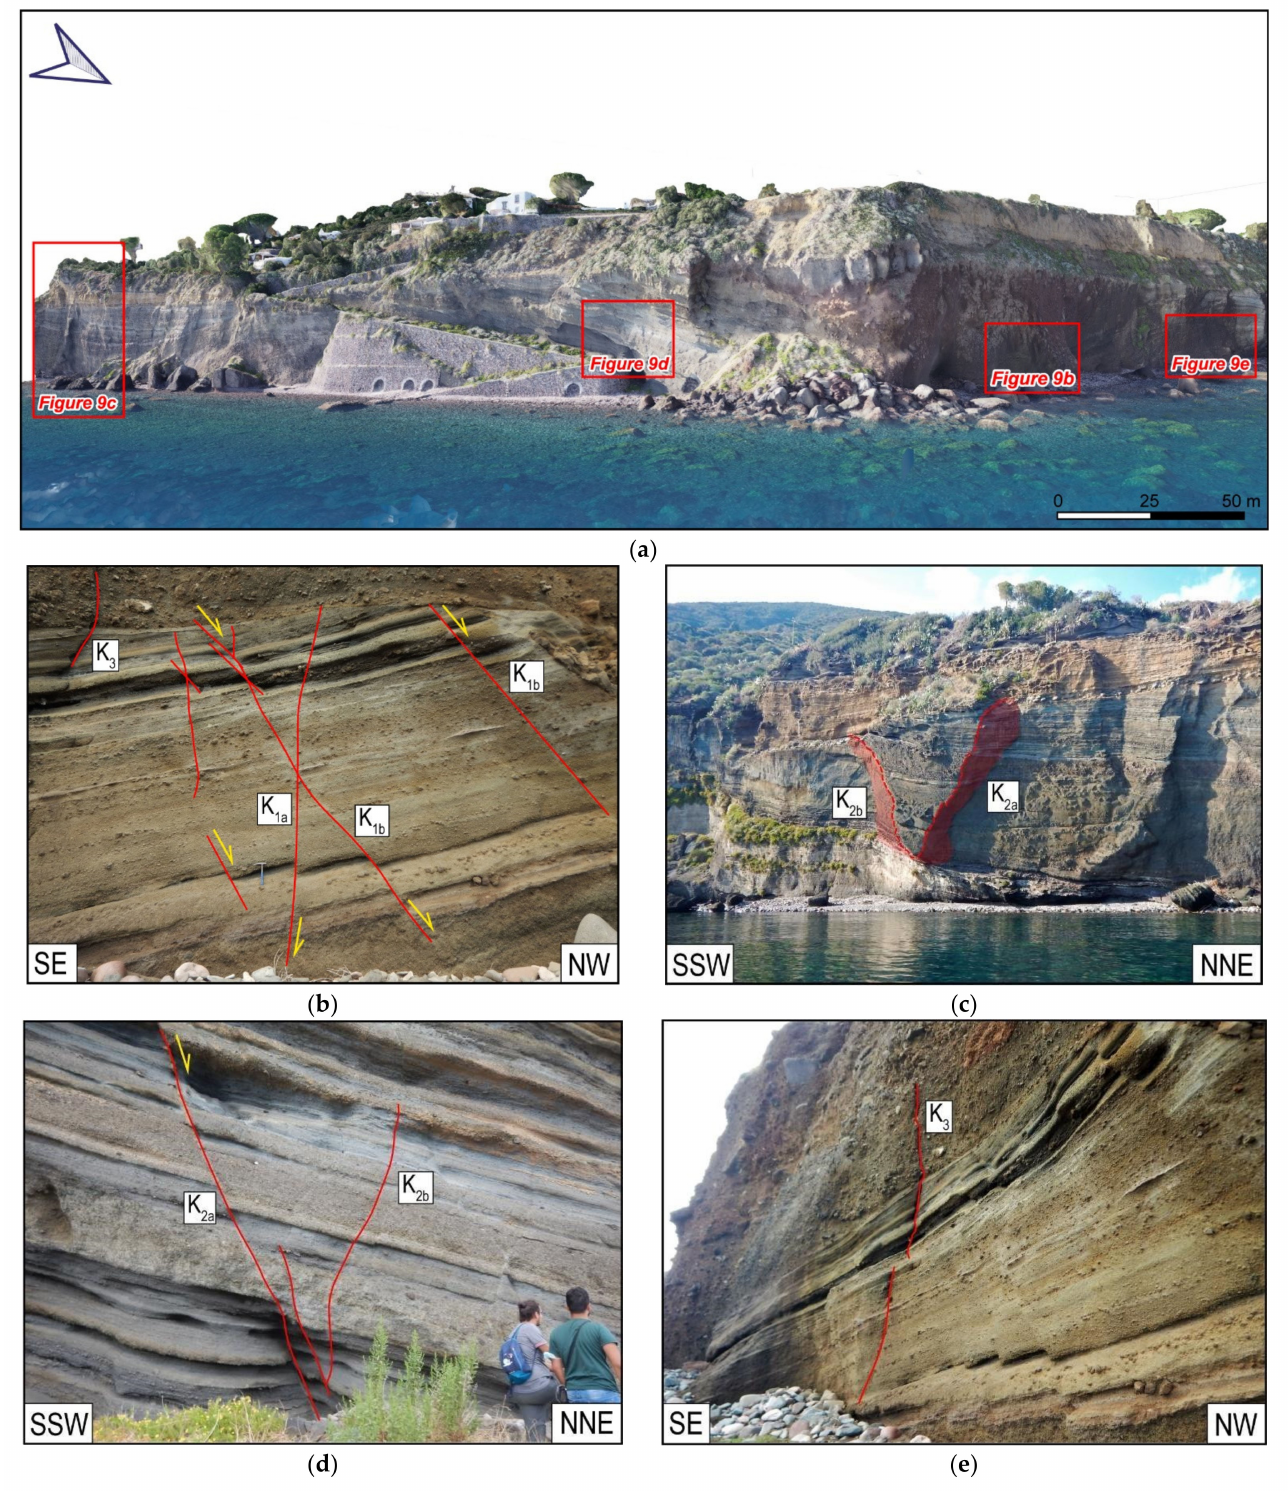
Figure 9. ( a ) 3D textured model focused on the vertical coastal cliff (red squares indicate the described outcrops). ( b – e ) shooting areas are indicated by red squares; ( b ) Pyroclastic deposits of the po affected by normal faulting of the K1 conjugated system (yellow arrow indicated the sense of displacement); ( c ) Boat–view of the cliff affected by K2a and K2b conjugated faults, intersecting forming a wedge; ( d ) K2a and K2b conjugated faults with a normal sense of displacement (indicated in yellow); ( e ) K3 discontinuity cutting the alternance of pyroclastic layers with different cementation degree of the po